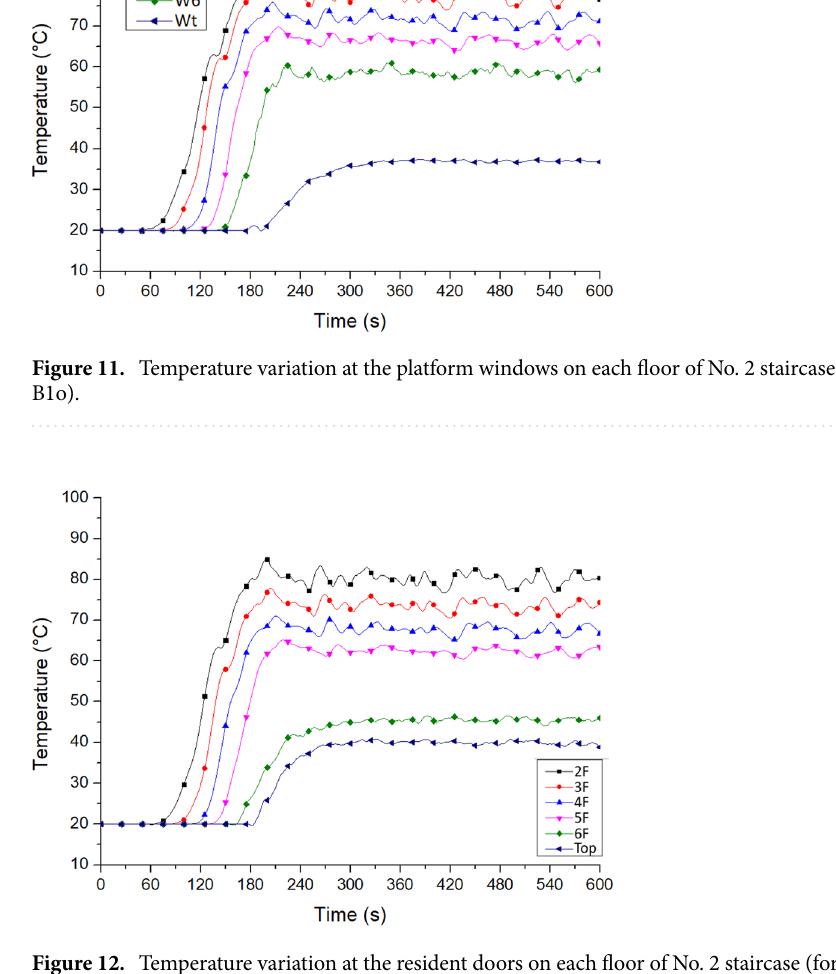
Figure 12. Temperature variation at the resident doors on each floor of No. 2 staircase (for Case